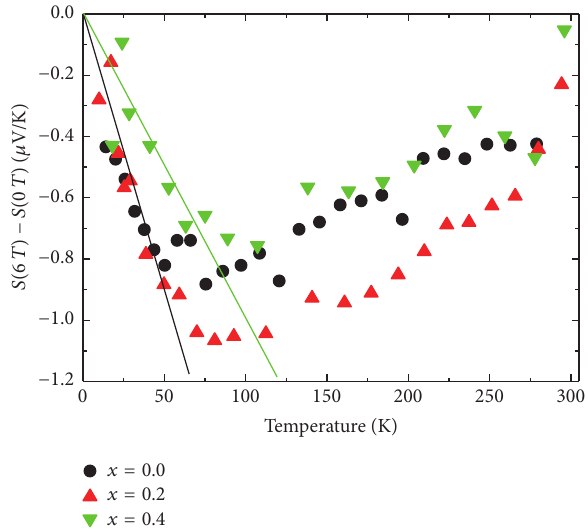
Figure 2: Plot of the Sr 2−𝑥 La 𝑥 FeMoO 6 thermopower at 6 T minus the thermopower at 0 T for 𝑥 = 0 (filled circles), 𝑥 = 0.2 (filled up triangles), and 𝑥 = 0.4 (filled down triangles). The lines are guides to the